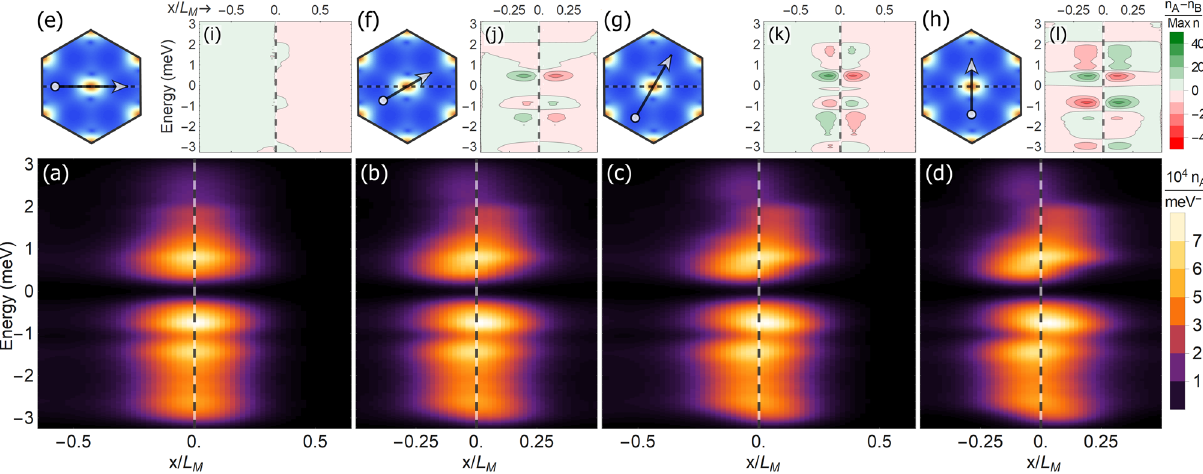
Fig. 3 Nematic signatures in the local density of states (LDOS). a – d Sublattice-resolved (sublattice A ) top layer electronic LDOS n A of the nematic superconducting state contour plotted along four different real space cuts (black line shown in e – h ). The moiré cell center, x / L M = 0, is marked by dashed lines. e – h Illustrations of the line cuts along which the LDOS is shown in a – d , starting at the base and ending at the arrow tip. The cuts are shown on top of the superconducting order parameter fi eld amplitude where the dashed line shows the nematic axis of the order. In the normal state, the cuts a and c are equivalent by symmetry, and so are cuts b and d . The normal state LDOS is therefore the same in each pair of cuts and also symmetric around the moiré cell center, but this symmetry is lifted by the nematic superconducting order in a – d . i – l Contour plots of the sublattice LDOS polarization, i.e the LDOS difference between sublattice A and B , n A − n B , along the cuts of e – h , where green shades indicate a larger LDOS on sublattice A , while red shades indicate a larger LDOS on sublattice B . The LDOS polarization is measured relative to the maximal LDOS, Max n , and each contour marks a 10% change relative to this maximal LDOS. In all fi gures, the coupling strength is J = 0.43 t and the Fermi level is aligned with the upper van Hove singularity (conclusions are qualitatively unchanged for other J / t Adding a phase factor Δ ↦ e i ϕ Δ in the bottom layer, we plot in Fig. 4b the resulting superconducting condensation energy as a function of the interlayer phase difference ϕ . For roughly half of the available phase space, the superconducting state is unstable with a total energy higher than in the normal state. This extraordinarily stiff energy-phase relationship proves that the π - shift is central for the existence of superconductivity.